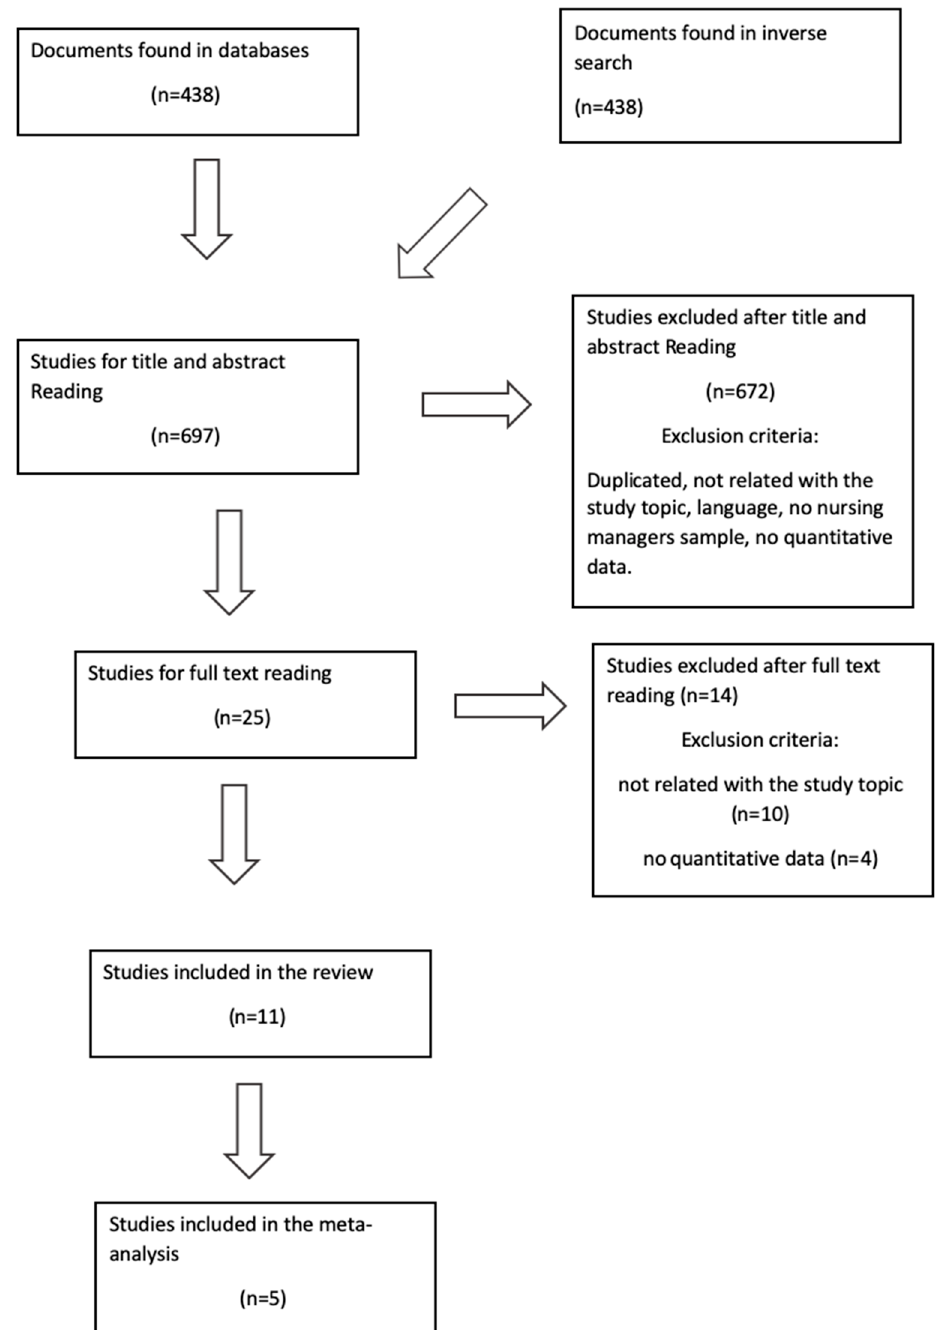
Figure 1. Flow diagram of selection process.